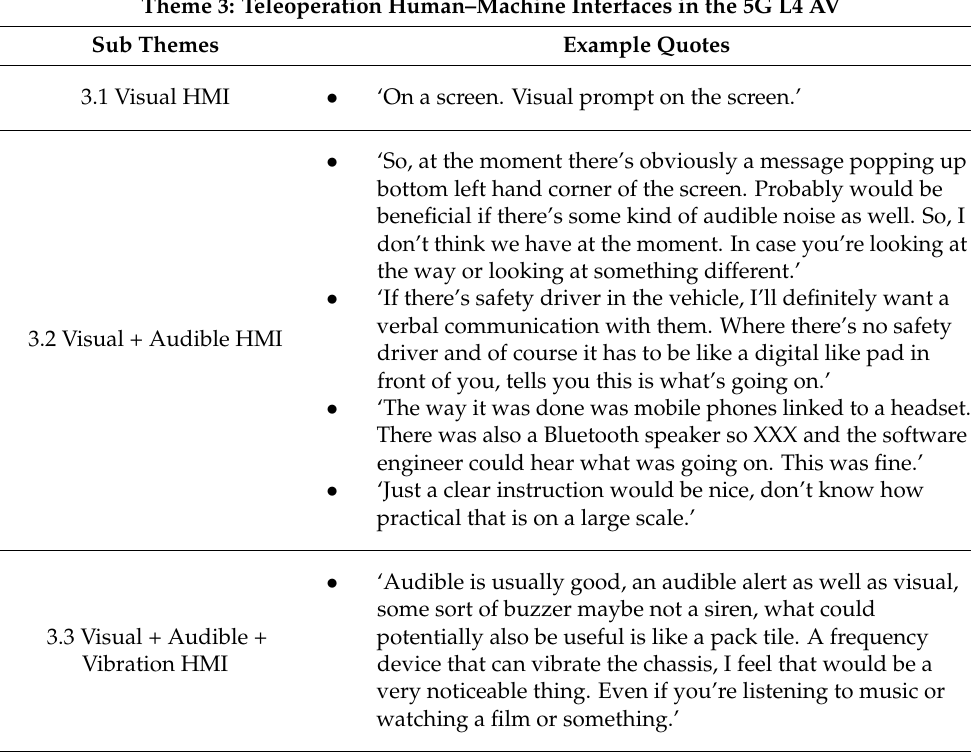
Table 3. Theme 3: Teleoperation human–machine interfaces in the 5G L4